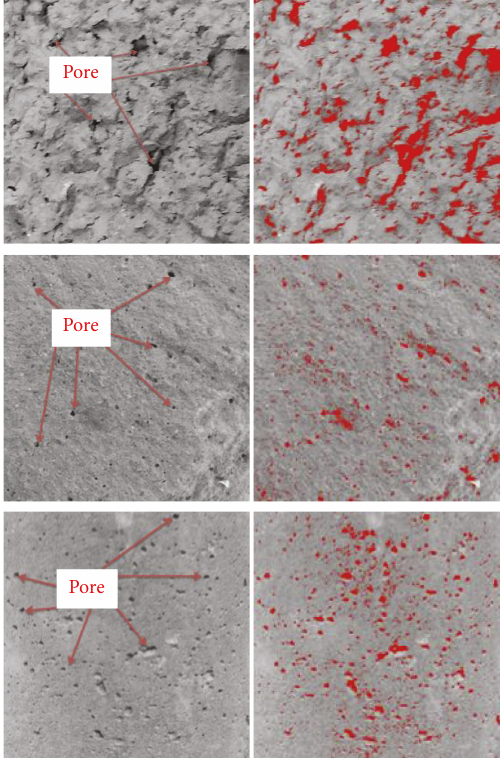
Figure 6: Illustration of image processing for specimens. Table 3: Input parameters for the numerical